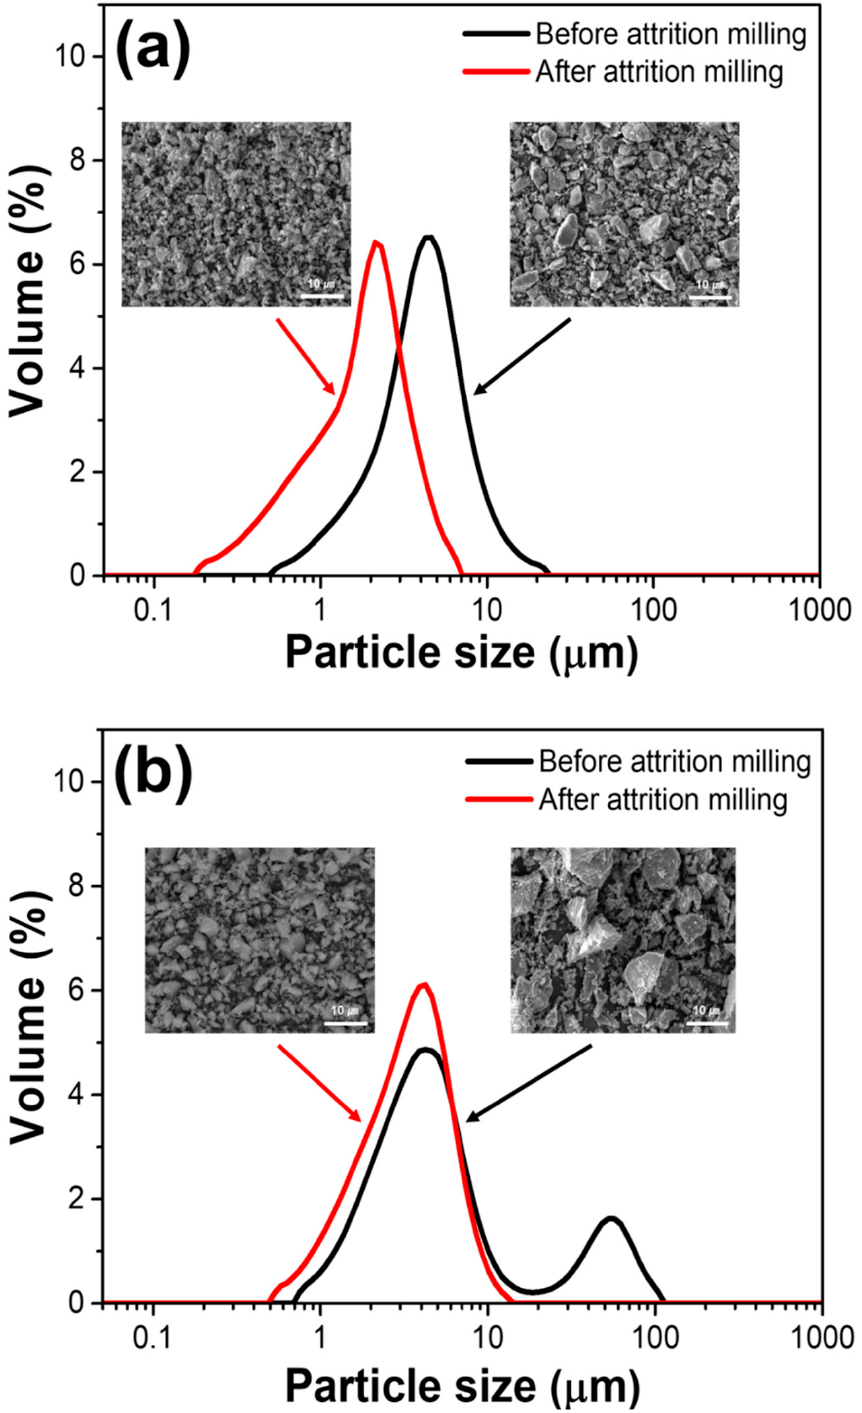
Figure 2. Particle size distributions of the starting powders: ( a ) mullite and ( b ) cordierite. The inset images show the SEM micrographs before and after attrition milling of the starting powders (mullite, cordierite).